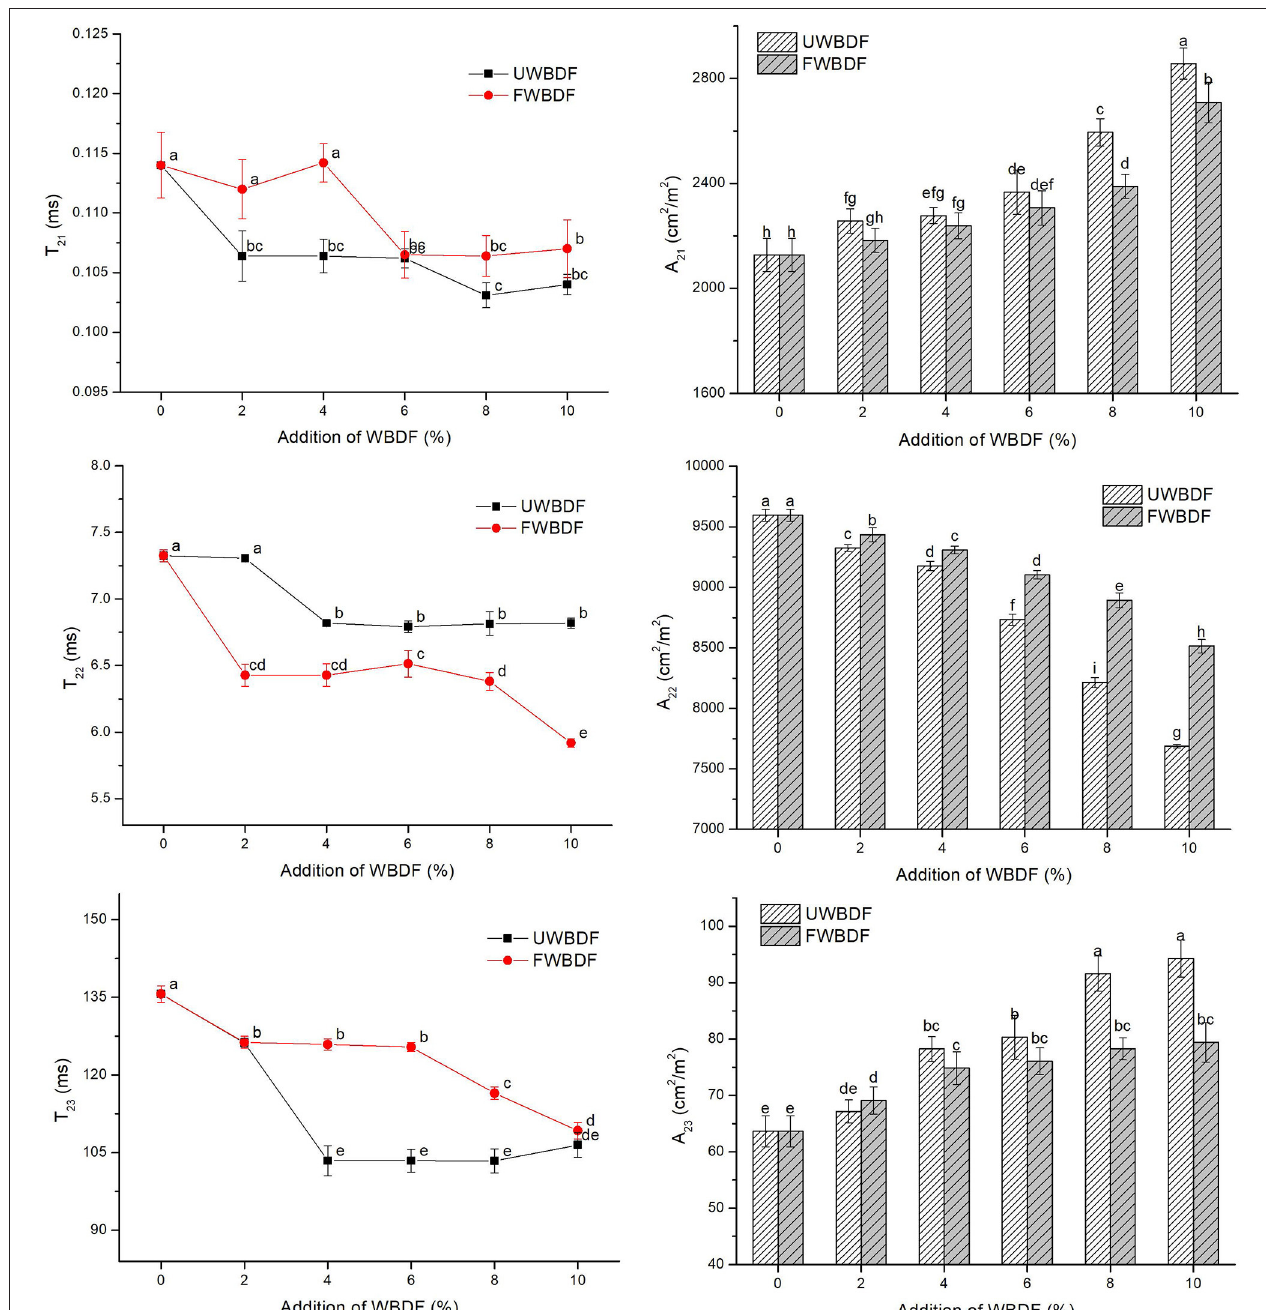
FIGURE 3 | Effect of UWBDF and FWBDF addition on the water distribution of